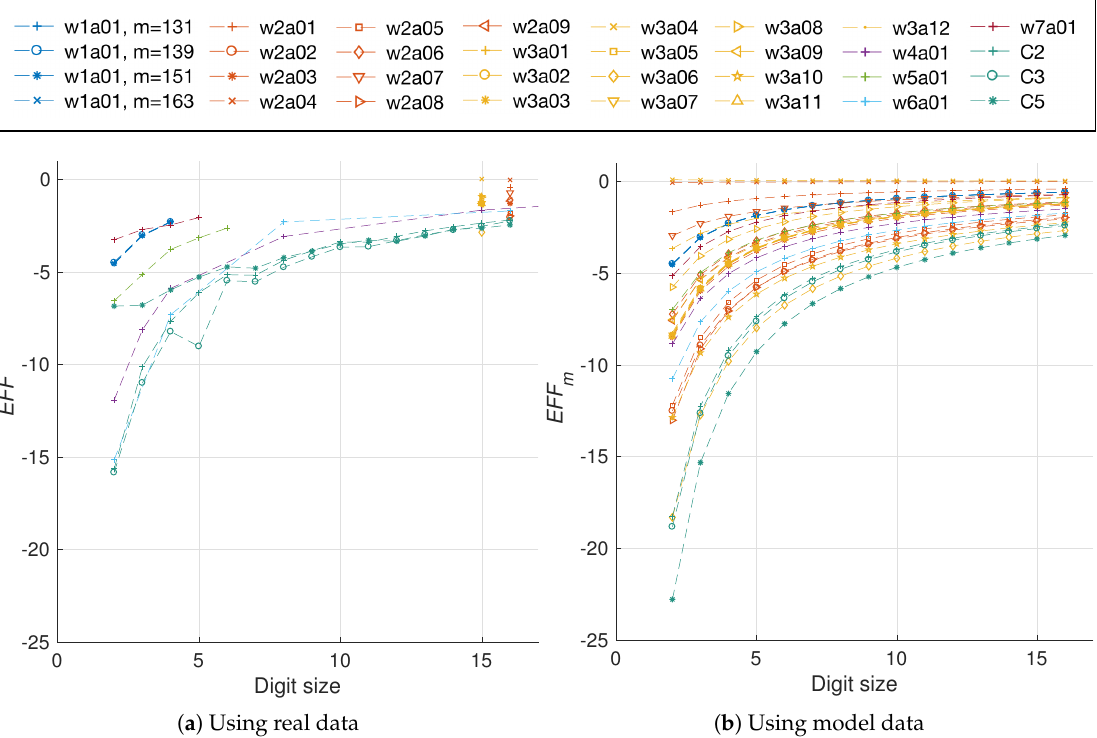
Figure 15. Evaluation of the efficiency metric for the different works in the literature, ours included.